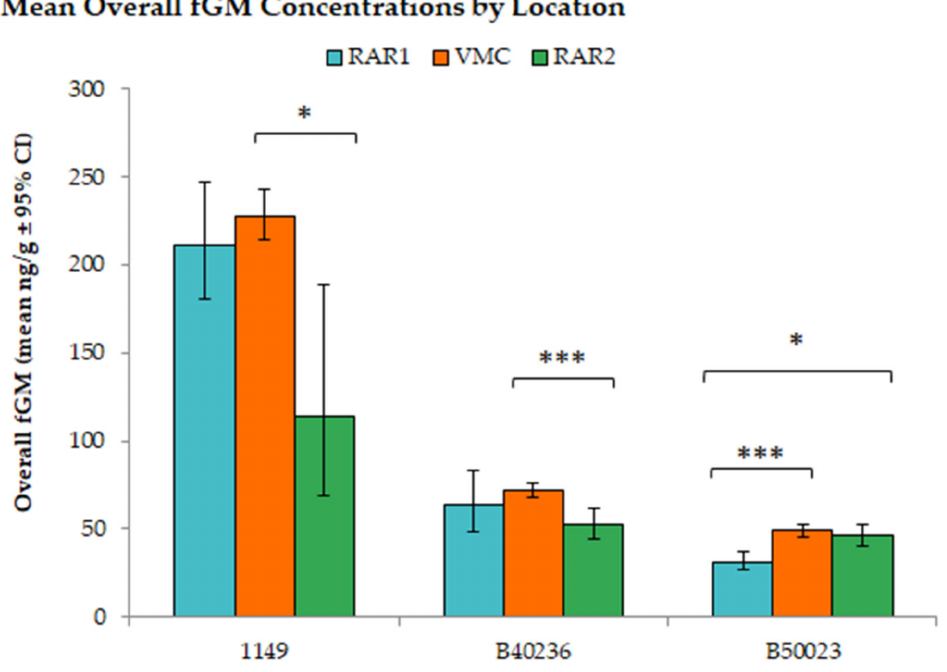
Figure 2. Average overall fGM concentrations (ng/g) by location and focal animal. A type I, two-way ANOVA with Games–Howell post-hoc comparisons showed multiple significant